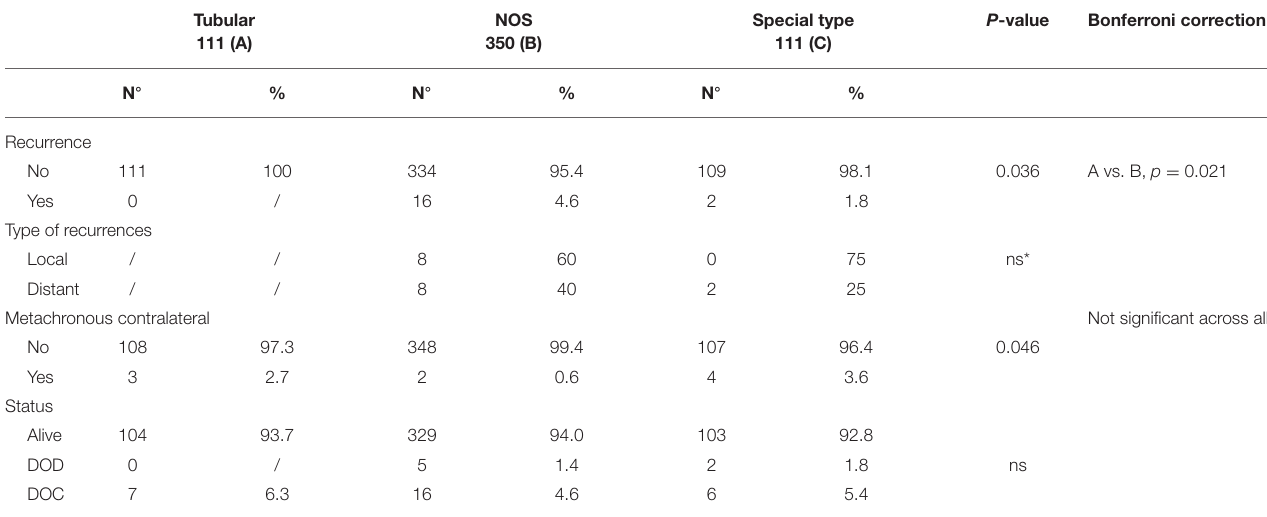
TABLE 2 | Follow-up analysis of the whole case series stratified according to histotype. Tubular 111